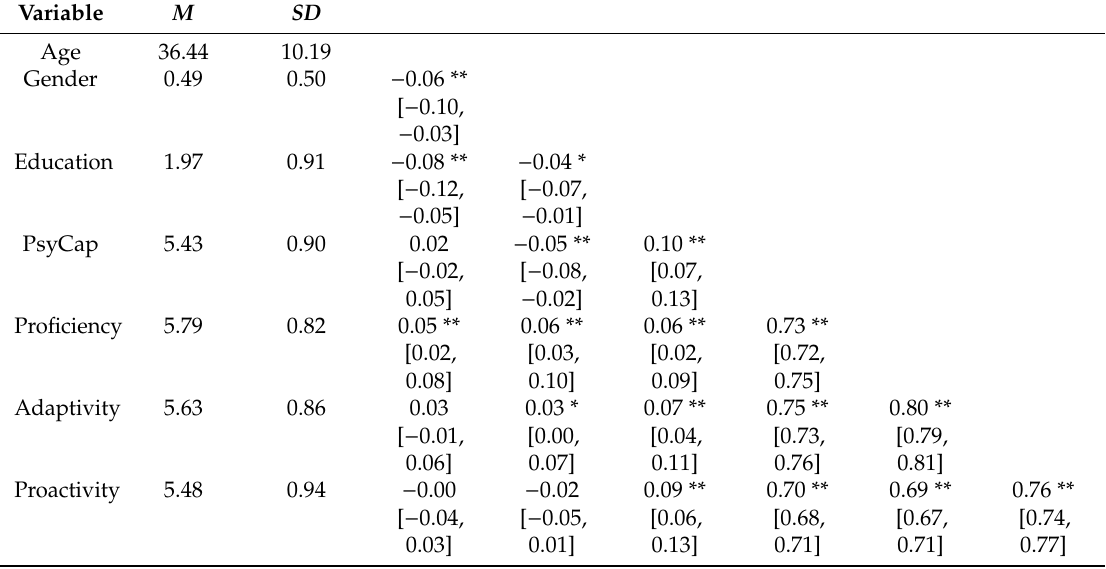
Table 1. Means, standard deviations, and the intercorrelations among study